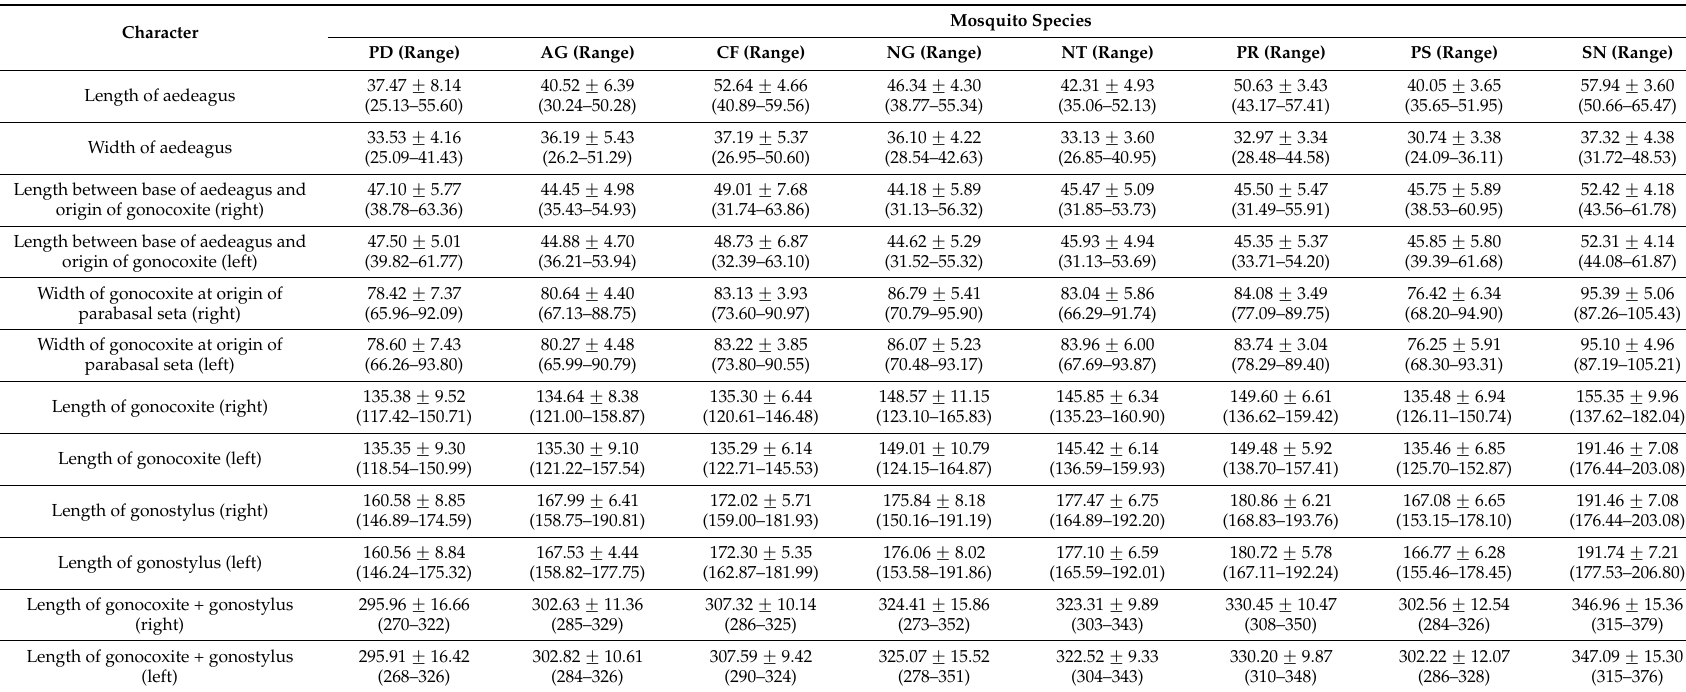
Table 6. Comparisons of measurements (length and width in microns) of male genital structures in the eight species of the Hyrcanus Group (30